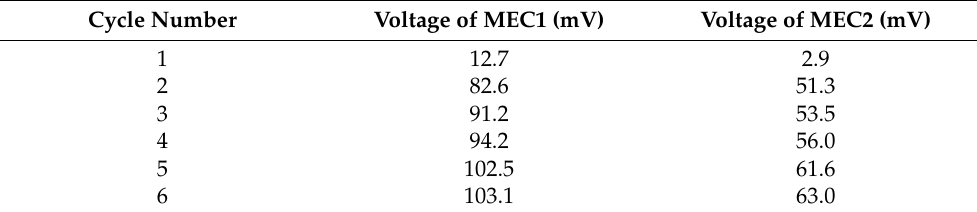
Table 1. Maximum voltage obtained during the acclimation phase of MEC1 and MEC2 (operated as MFC, R = 100 Ω) for six cycles of operation.